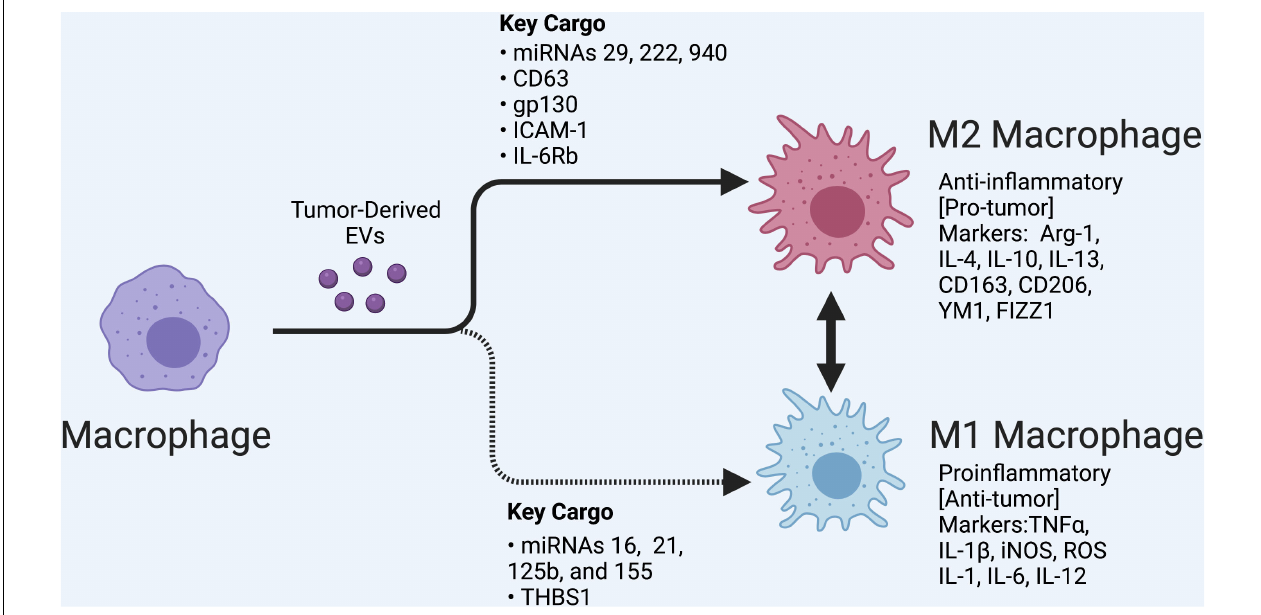
FIGURE 1 | Macrophage polarization regulated by tumor-derived extracellular vesicles (EVs). A variety of tumors release EVs that can modulate tumor-associated macrophages depending in part on their cargo, as shown. M1 and M2 subsets are shown along with classifying cell markers. EVs can also regulate the transition between these polarization states. In the tumor microenvironment, polarized states across a spectrum are likely observed. Created with